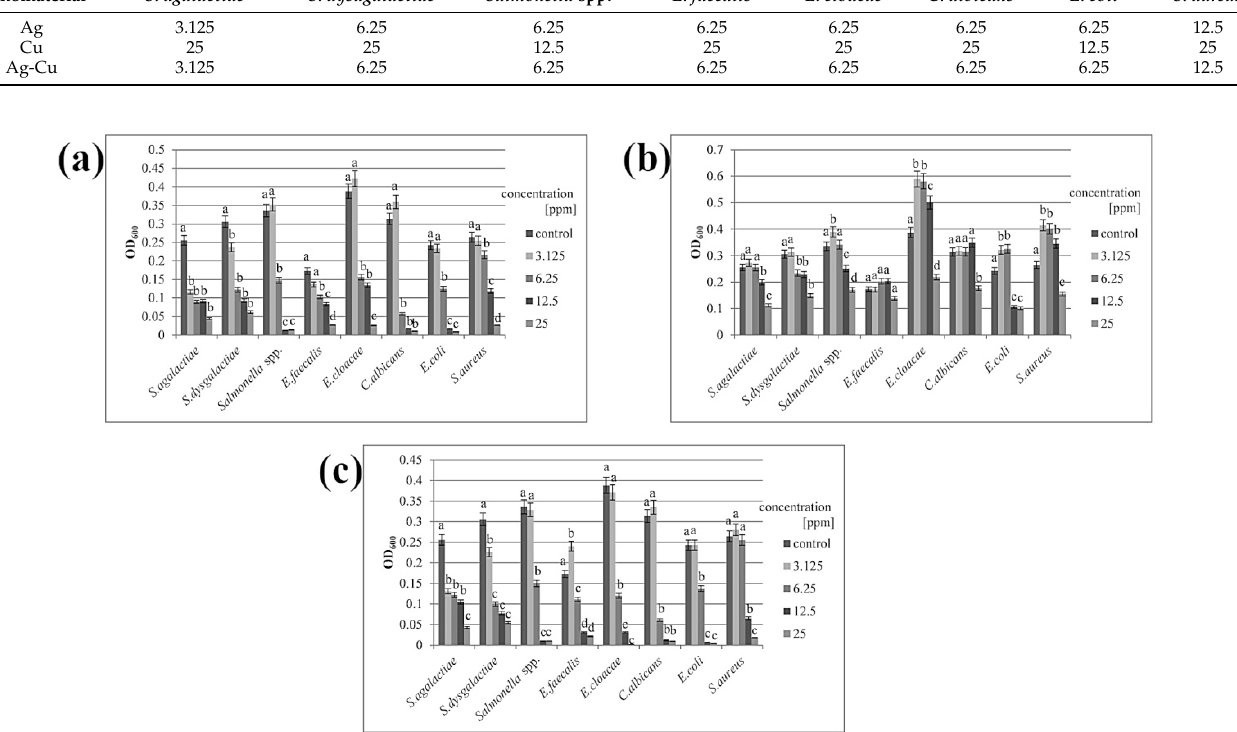
Table 2. Values of minimal inhibitory concentration (ppm) of the nanoparticles used (Ag, silver nanoparticles; Cu, copper nanoparticles; Ag-Cu, silver–copper complex) for each microorganism strain. Nanomaterial